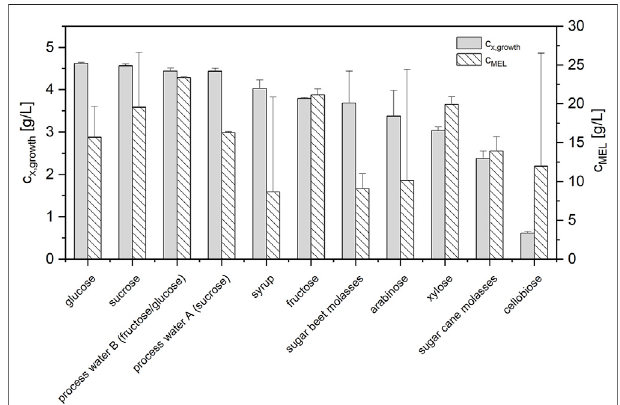
FIGURE 4 | Maximum biomass concentrations ( n = 3) for different sugar substrates during growth and correspondingMEL concentrations ( n = 2) after asubsequentproductionphaseon8%rapeseedoil.Allsugarsubstrateswere employed at a total sugar concentration of 30 g/L to ensure direct